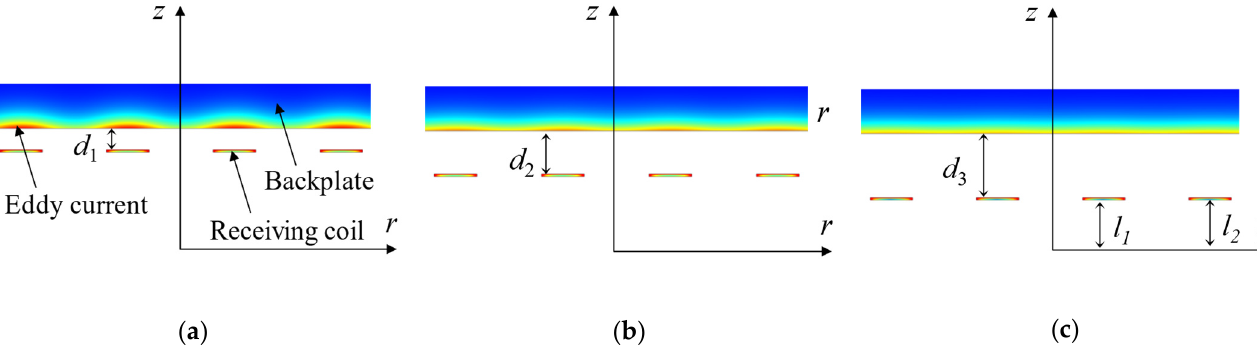
Figure 2. Section views of the eddy-current distribution when receiving coil–backplate gap, showing ( a ) d 1 , ( b ) d 2 and ( c ) d 3 separately, of which, d 1 < d 2 < d 3 .